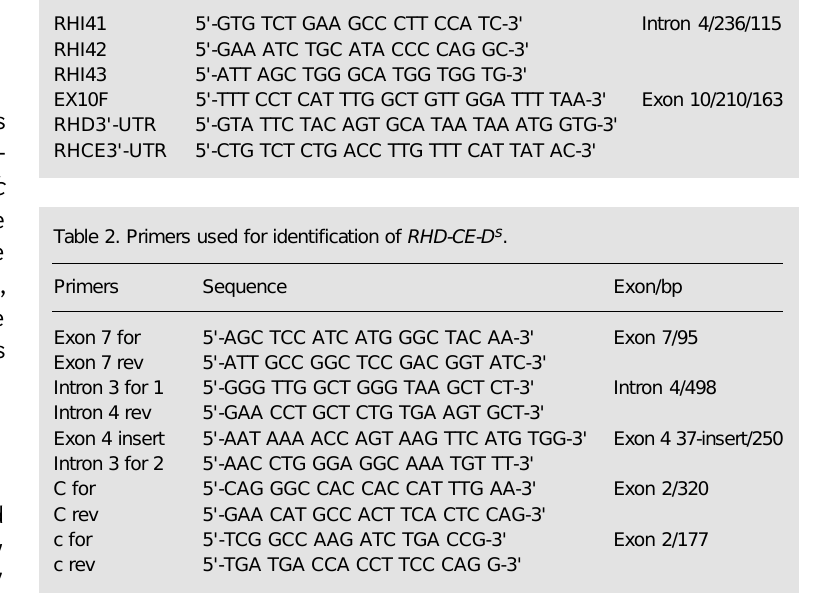
Table 1. Multiplex PCR for the presence of the RHD pseudogene